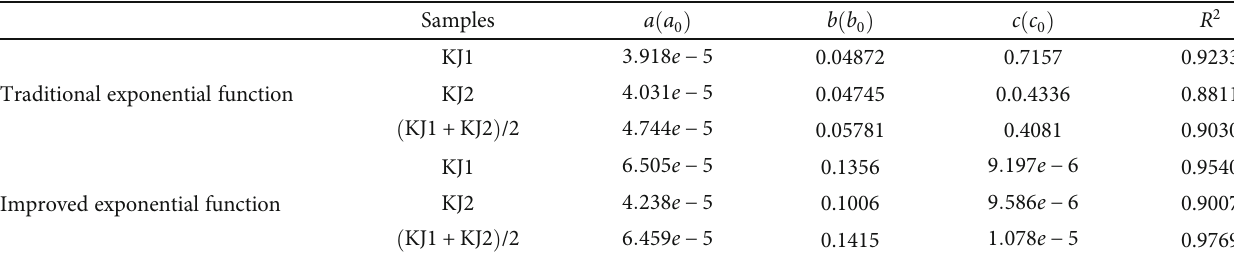
Table 3: The fi tting